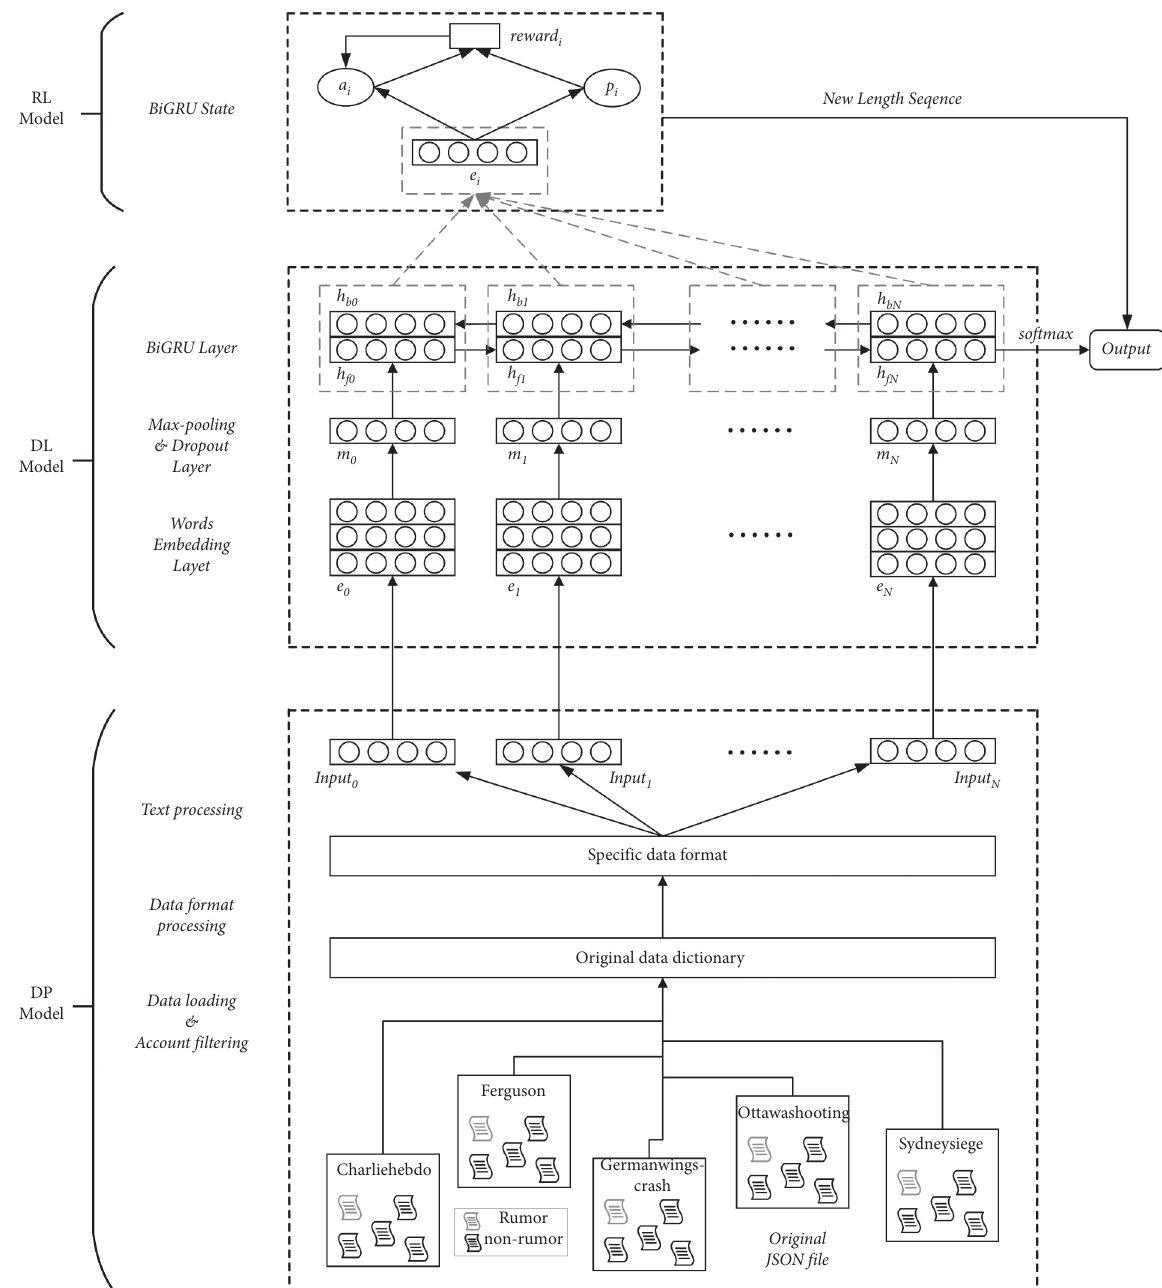
Figure 2: Architecture of DDR (data preprocessing and rumor detection based on deep learning and reinforcement